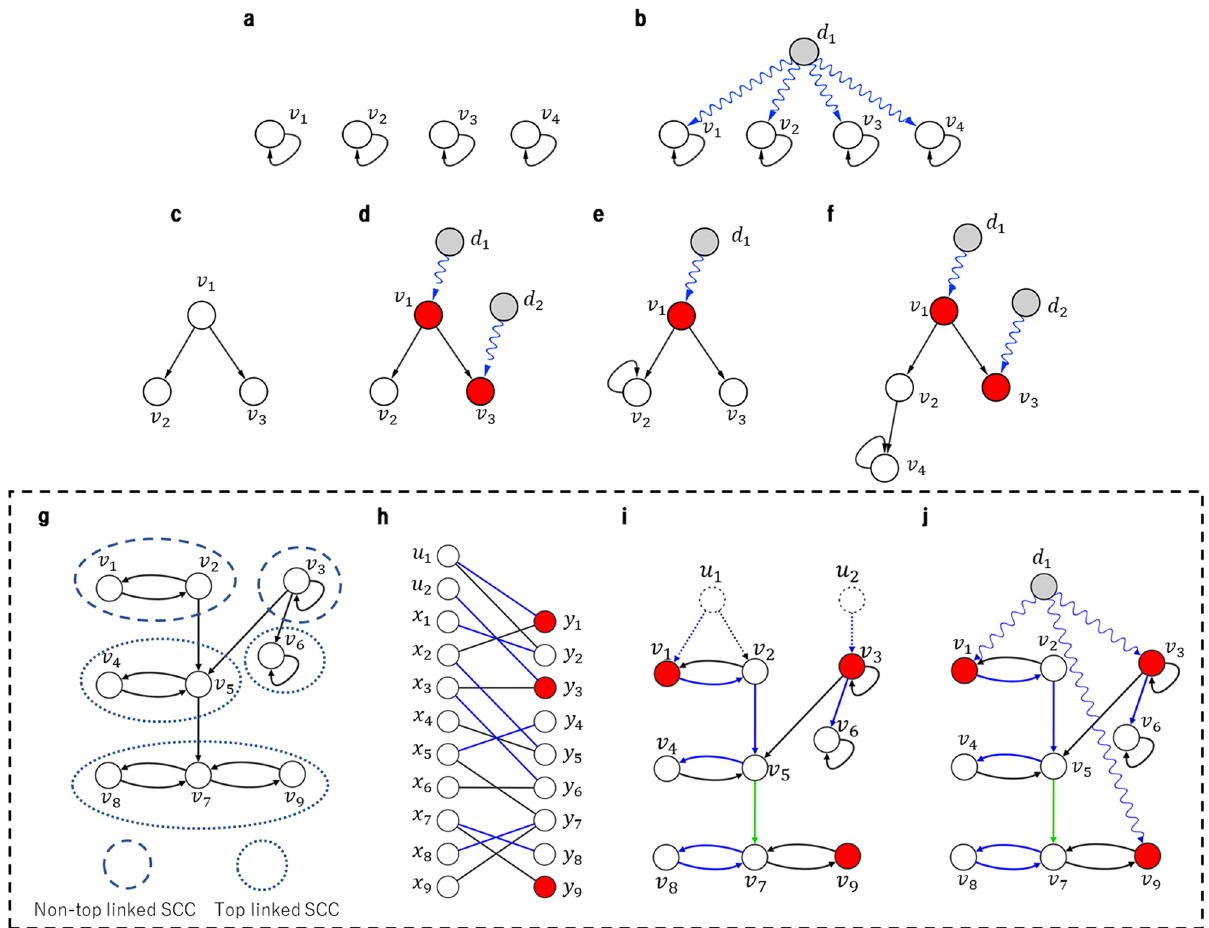
Figure 1. ( a ) Example of an original network with loops. ( b ) Using the MM theory, the entire network can be controlled by a single driver node ( d 1 ). Outgoing control signals are denoted in wavy blue arrows. ( c ) Example of a network without loops. ( d ) The network is controlled by driver nodes d 1 and d 2 ). ( e – f ) By adding a loop, the number of driver nodes decreases. (g) Example of an original network G(V,E). SCC denotes Strongly Connected Component . ( h ) Bipartite Graph ( V L , V R , E B ) and its bipartite matching (blue edges). ( i ) Stems and a bud obtained from the matching. The green edge ( v 5 , v 7 ) does not correspond to a matching but is included in a bud. ( j ) A single multi-signal driver node d 1 controls three driven nodes (red). The computation of the MM may lead to a number of driver nodes that is smaller than that of the driven